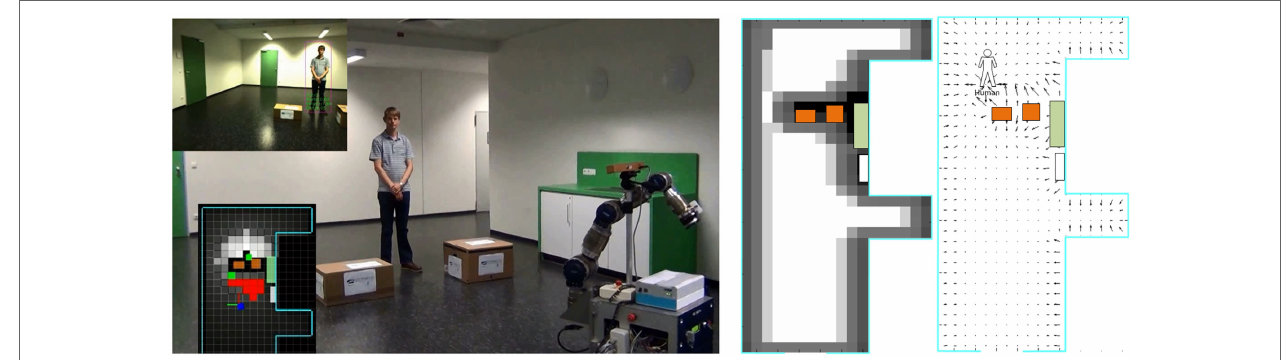
FiGUre 3 | Empowerment-driven robot follower as described in Leu et al. (2013). The robot tries to follow the human while trying to maintain its empowerment in the obstacled environment. By trying to maintain empowerment, the robot keeps away from obstacles and walls and, furthermore, avoids passing through the narrow passage separating it from the human because it would constrain its movement. The left subfigure shows the experimental setup, with a scaled empowerment map on the bottom left. The top left shows the robot’s view, used for tracking the human. The right subfigure shows the room layout with empowerment map overlaid; right: gradient vector field of the scaled empowerment map, scaled by Euclidean distance to the human to induce following